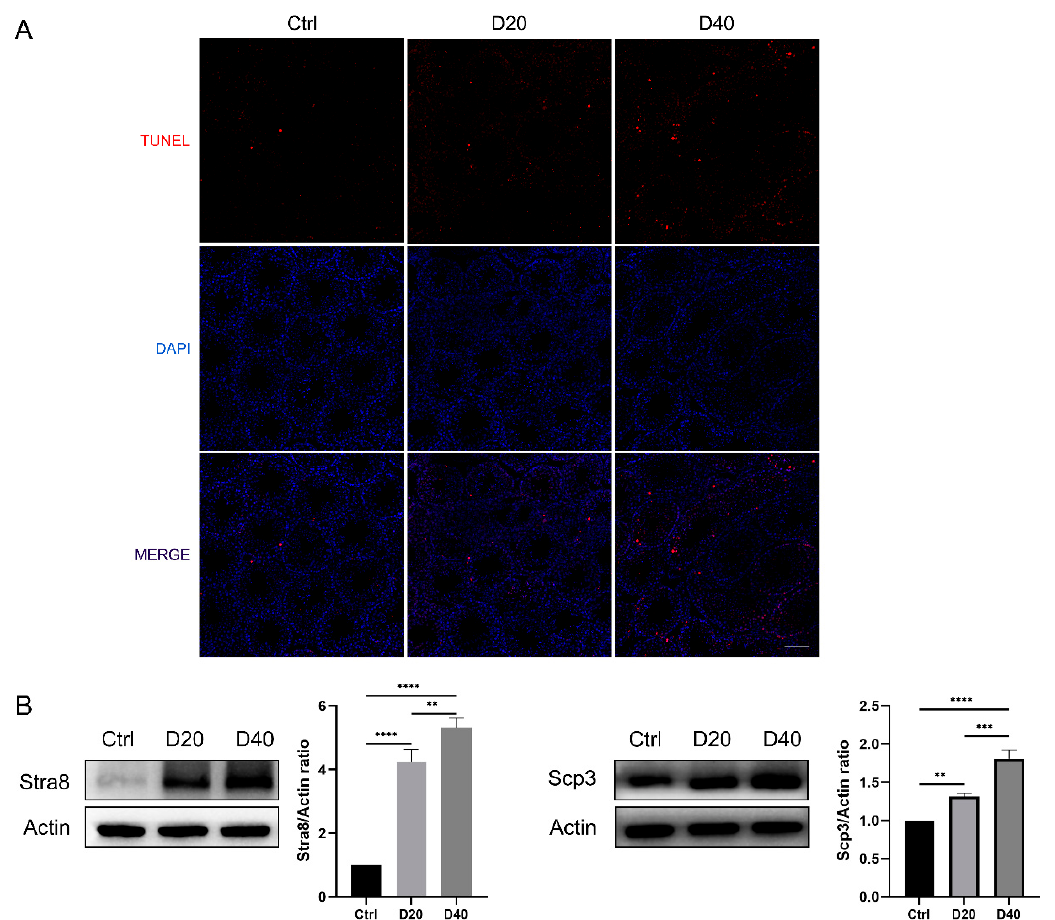
Figure 3. DFZ exposure induces increased apoptosis and abnormal meiosis in testicular tissues. ( A ) TUNEL staining of testicular tissue (the scale bar represents 100 µm) and ( B ) protein (Stra8 and Scp3) expression levels in different groups. ** p < 0.01, *** p < 0.001 and **** p < 0.0001 versus the